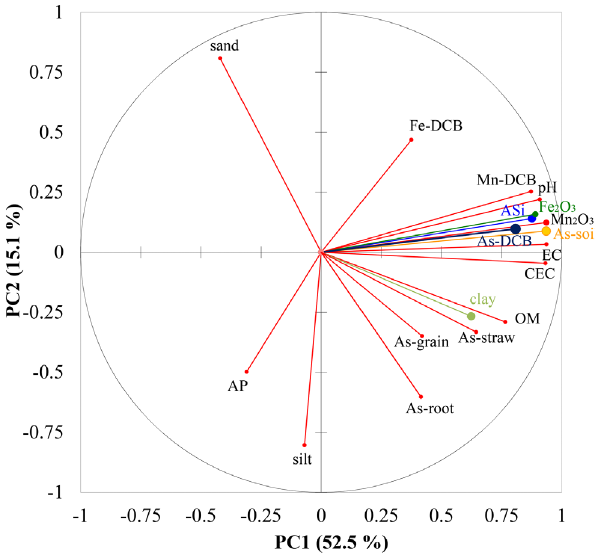
Figure 2. Plot of the first two principal components from Principal Component Analysis (PCA). The PCA was performed with As, Fe and Mn in DCB extracts, total As in soil, Fe 2 O 3 and Mn 2 O 3 , available phosphorus (AP) and Si (ASi), selected soil properties, As in rice tissues.